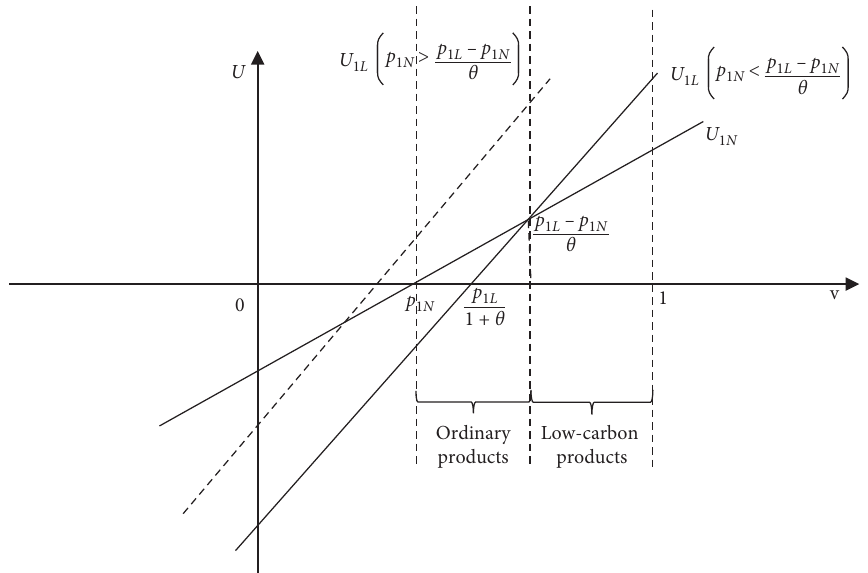
Figure 2: Relationship between consumer willingness and